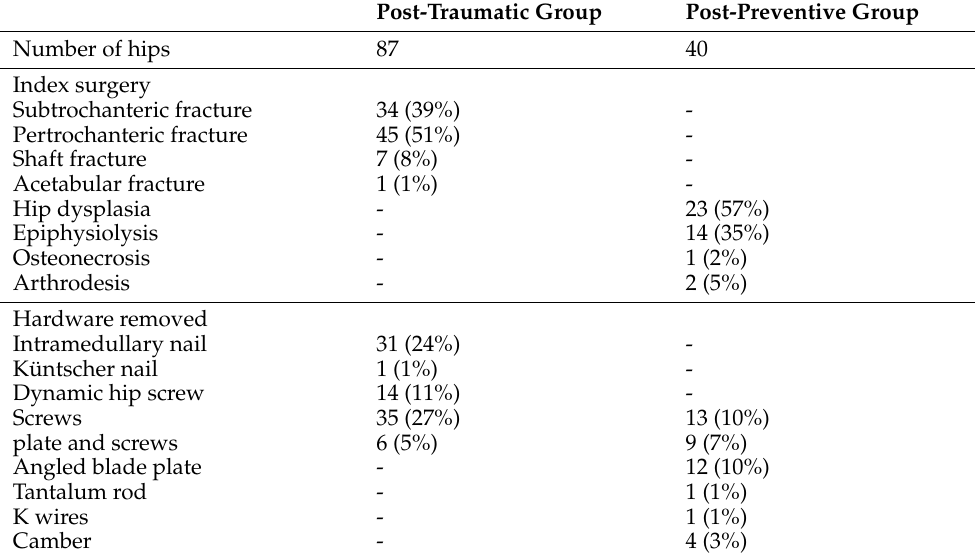
Table 2. Pathological and implant